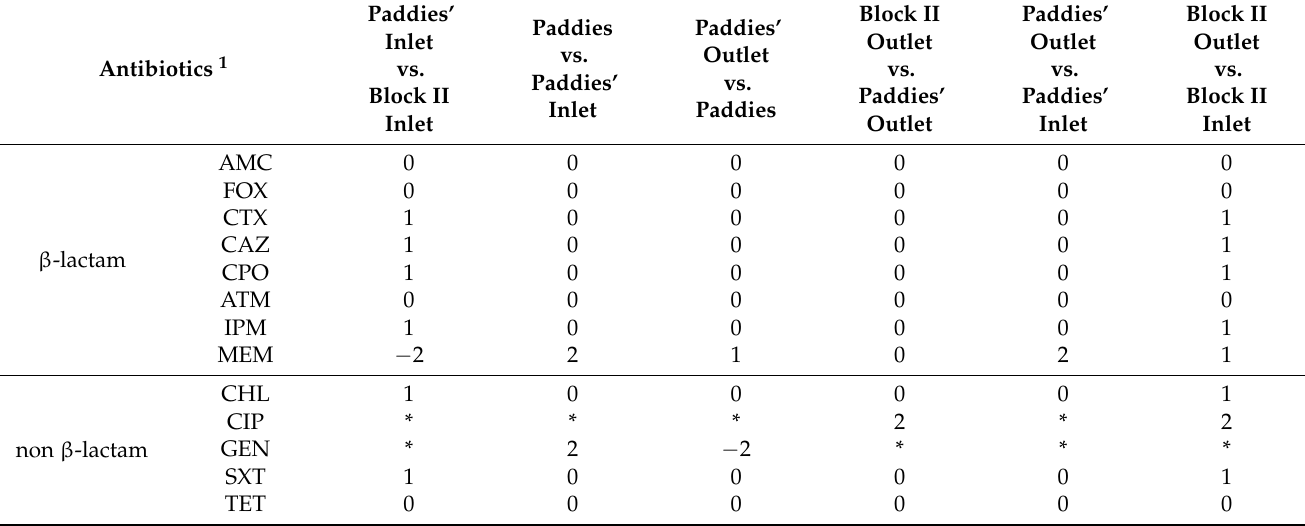
Table 3. Relative variation of the resistant percentage to the β -lactam and non β -lactam classes of samples collected on several sites of the water paths of